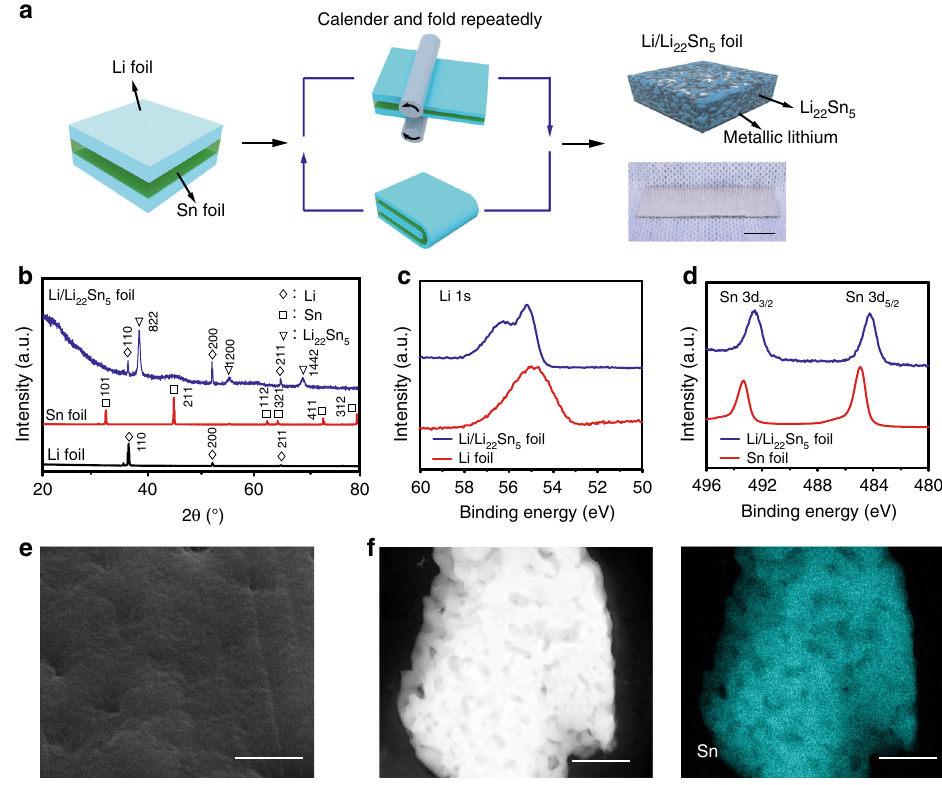
Fig. 1 Fabrication and characterizations of the Li/Li 22 Sn 5 nanocomposite foil. a Schematic of the fabrication of the Li/Li 22 Sn 5 nanocomposite foil. Two pieces of Li metal foils and one piece of Sn foil were stacked together to form a Li – Sn – Li sandwich. Repeated calendaring and folding operations were performed for the Li – Sn – Li sandwich, producing periodically stacked metallic lithium and tin nanolayers with rich amount of Li/Sn interfaces. The metallic lithium and tin reacted spontaneously at these freshly formed interfaces, and formed a Li/Li 22 Sn 5 nanocomposite foil. The photo of the Li/Li 22 Sn 5 nanocomposite foil is shown in the bottom right (scale bar, 1 cm). b X-ray diffraction (XRD) patterns of the starting Li foil, Sn foil and the as-fabricated Li/Li 22 Sn 5 foil. c , d High-resolution Li 1s ( c ) and Sn 3d ( d ) X-ray photoelectron spectroscopy (XPS) spectra for the pristine metallic Li foil, metallic Sn foil, and the Li/Li 22 Sn 5 foil after surface cleaning by sputtering. e Top view scanning electronic microscopy (SEM) image of the Li/Li 22 Sn 5 foil (scale bar, 1 μ m). f Scanning transmission electron microscope (STEM) image of the Li 22 Sn 5 and the corresponding energy dispersive X-Ray (EDX) elemental mapping image for Sn (scale bar, 500 nm). After electrochemically stripping the metallic Li away, a three-dimensional (3D) interconnected Li 22 Sn 5 framework was